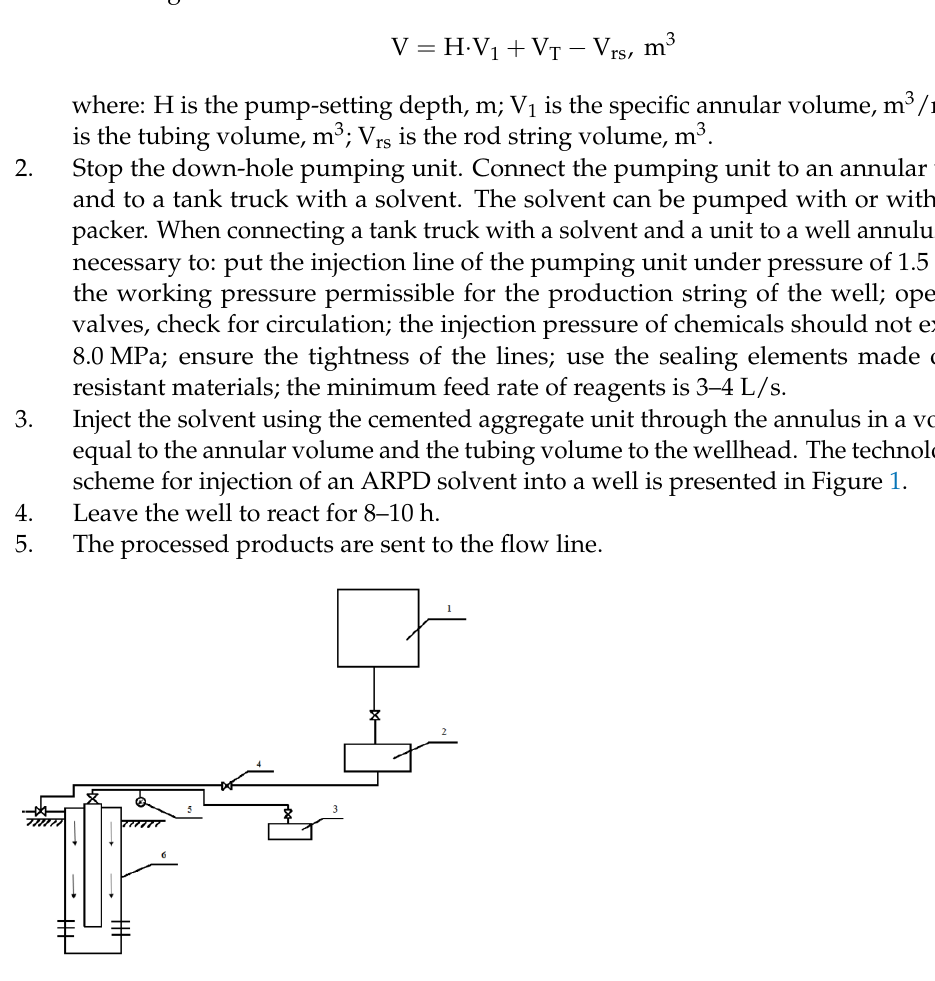
Figure 1. Technological scheme for injection of an ARPD solvent into a well. 1 — a tank truck with